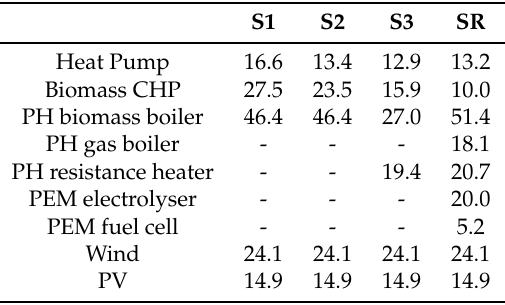
Table 9. Capacity factors of conversion units and RES.